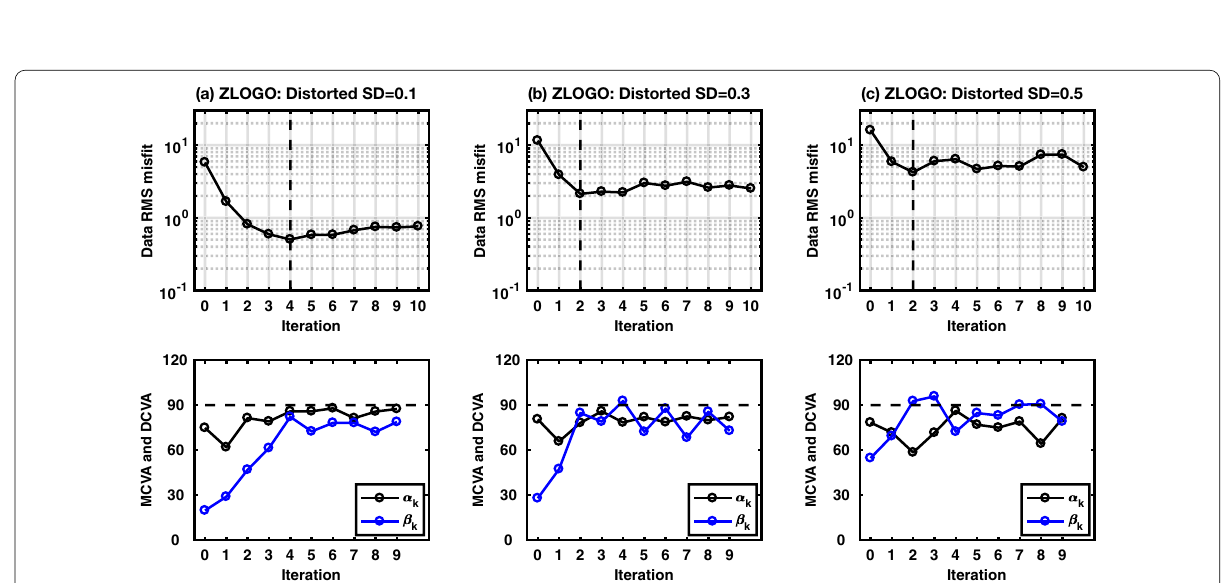
Fig. 18 dRMS (top, black solid curve with symbols) and the MCVA (bottom, black) and DCVA (bottom, blue) at each iteration step obtained from inverting ZLOGO distorted with SD values of a 0.1, b 0.3, and c 0.5 using SSQ1D as the initial model. Dashed lines in the dRMS plots indicate the iteration step, where the dRMS is